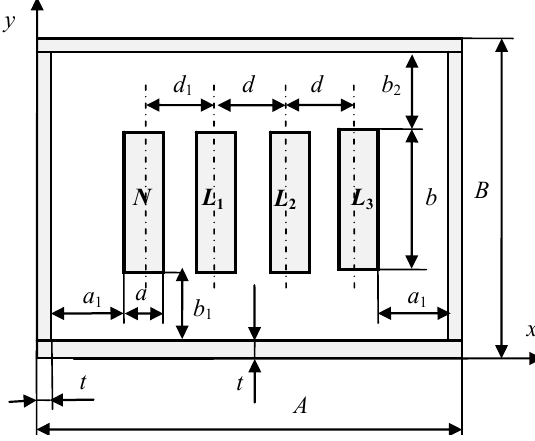
Figure 3. Shielded bus duct manufactured by the Holduct company [5].